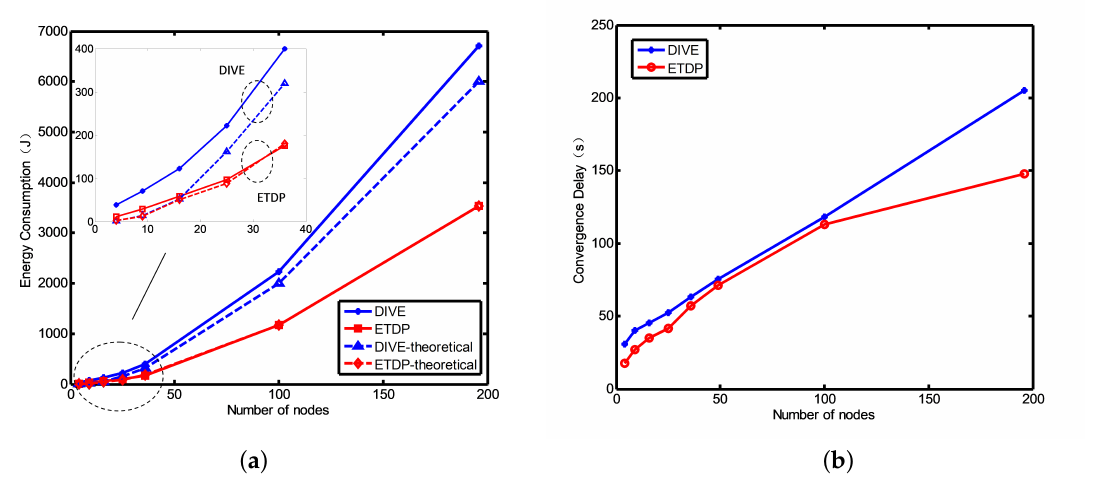
Figure 6. The performance comparison between the proposed ETDP and DIVE protocols: when PER = 0, ( a ) Energy consumption for network topology discovery; ( b ) Network topology discovery convergence